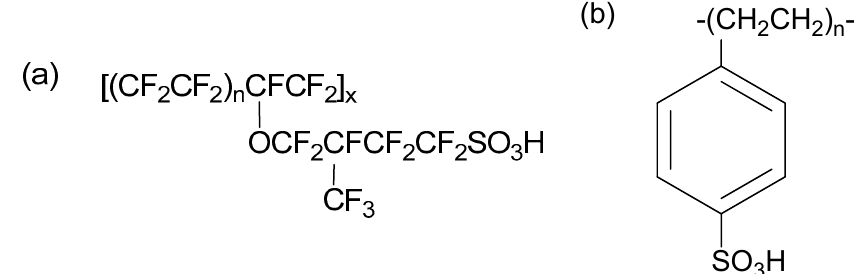
Figure 7. Structure of ion exchange resin catalysts: ( a ) perfluorinated resinsulfonic acid (Nafion) ( b ) sulfonated polystyrene (Amberlyst) [128,129].